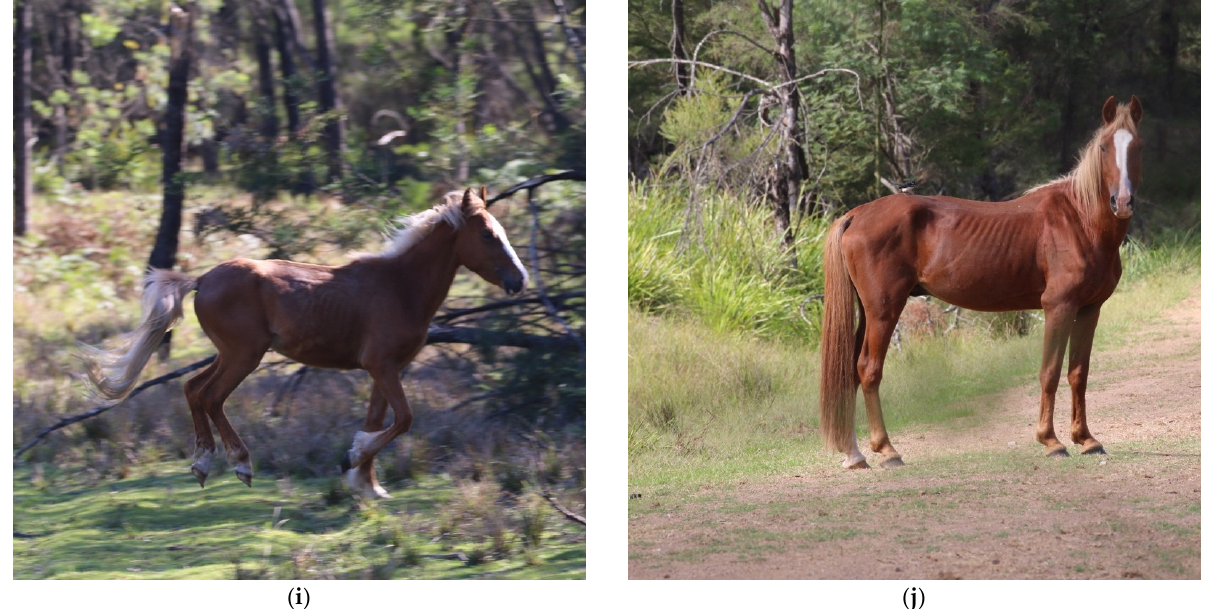
Figure 6. Examples of identification of horses and assessment of welfare indicators with direct observations (with 8–10× magnification), and some reasons for not being able to assess indicators. ( a ) Behaviour can be assessed but other indicators are obscured by vegetation. ( b ) Close spatial proximity with other horses can be assessed, but other indicators are obscured by vegetation. ( c ) At >100 m, behaviour is being observed without disturbing the horses, but the distance is too great to assess other welfare indicators. ( d ) At 100 m from the horse most welfare indicators can be assessed, but in this case the orientation of the horse prevents assessment of facial features and the right side of the horse. ( e ) At approximately 50 m, most welfare indicators can be assessed, but at this distance the observer will be seen by the horse, altering its behaviour. Distal limbs are obscured by vegetation. ( f ) Facial indicators can be assessed from approximately 50 m. ( g ) The detail of facial features is much greater <50 m to the horse but it is rare to be able to approach them so closely. ( h ) Trot is more readily assessed with direct observations. ( i ) Canter is more readily assessed with direct observations. ( j ) A good example of where most welfare indicators can be assessed on the right side of the horse, but at such a close distance behaviour is impacted by the observer’s presence. Photographs A.M. Harvey.